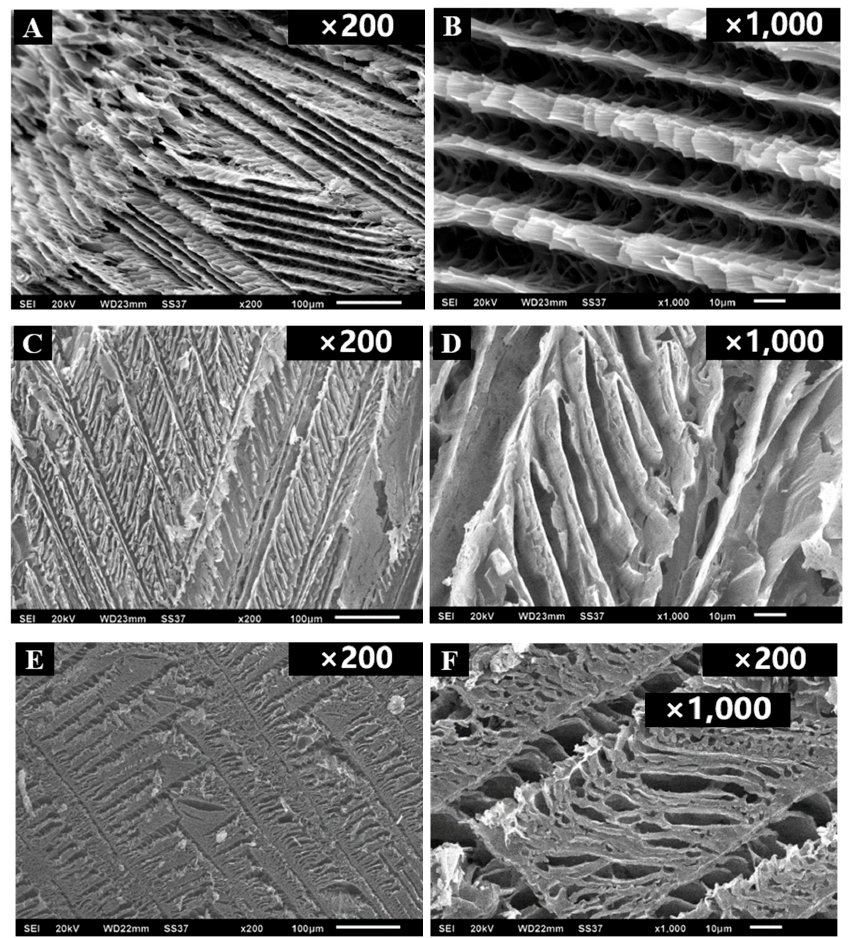
Figure 1. SEM images of aerogel samples. ( A , B ) P 5 ; ( C , D ) P 5 /S 0.001 , and ( E , F ) P 5 /S 0.5 . P x /S Y defines the polymer and sodium hydroxide concentrations used to produce the aerogels. the polymer and sodium hydroxide concentrations used to produce the